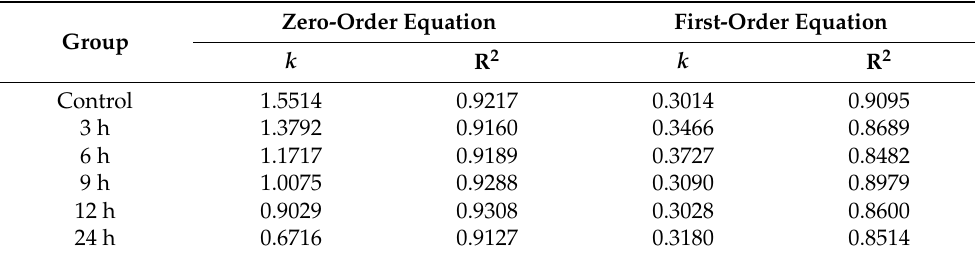
Table 1. Values of k and R 2 for zero-order and first-order equations of 3-DG formation in garlic with or without EGCG